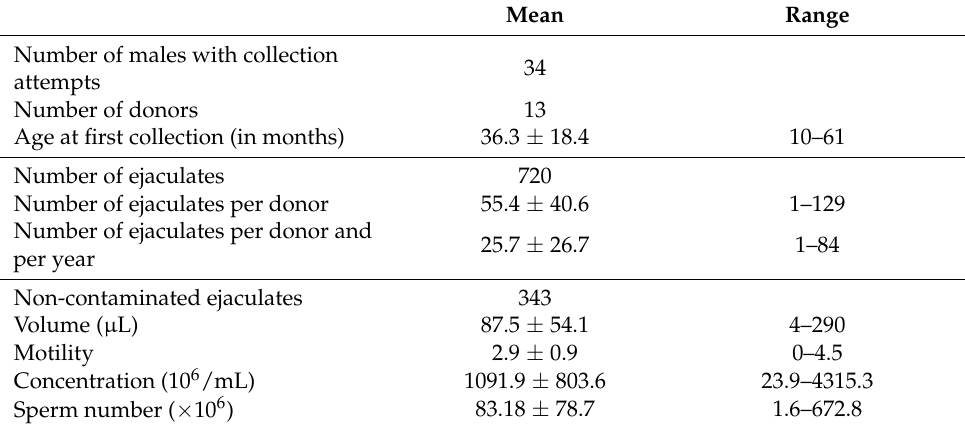
Table 1. Overall information on semen collection from 2019 to 2021. Only ejaculates that were not contaminated with urates, feces, or red blood cells were considered for overall semen characteristics. Means are presented along with standard deviations.